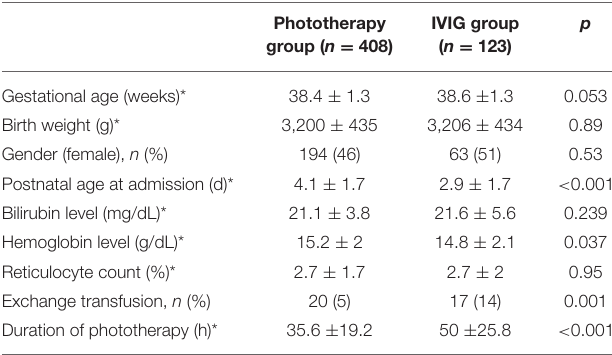
TABLE 1 | Demographic and clinical characteristics of the